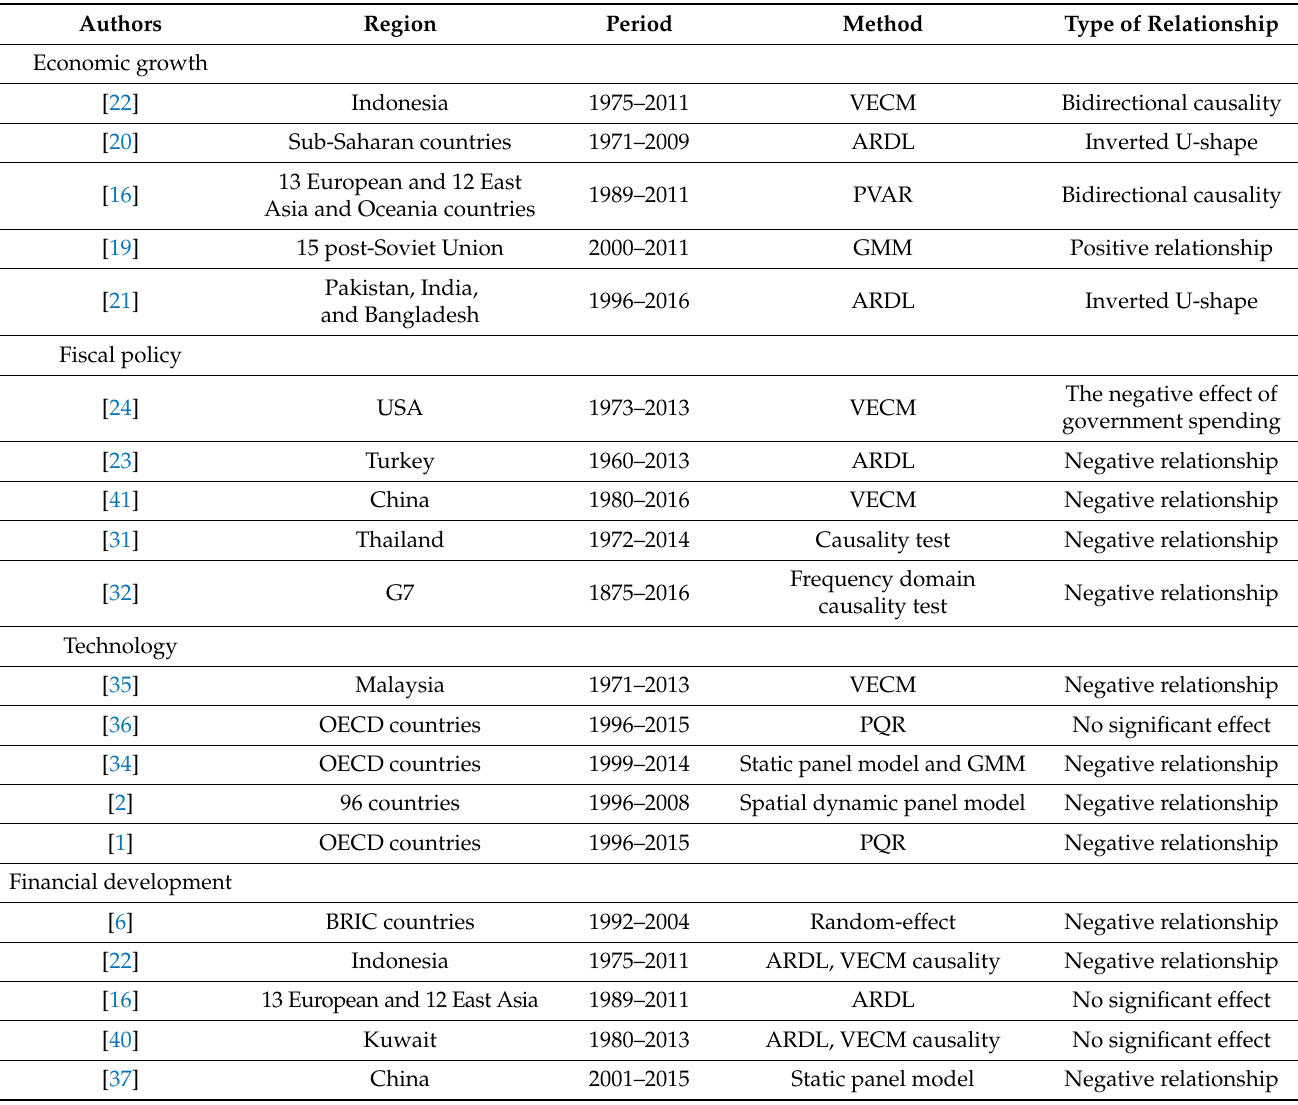
Table 1. Summary of the previous